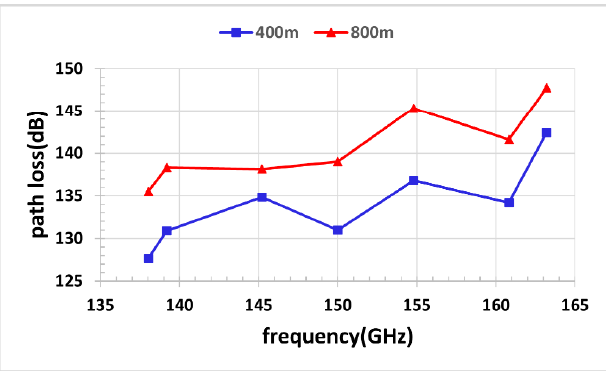
Figure 6. Path loss at distances of 400m and